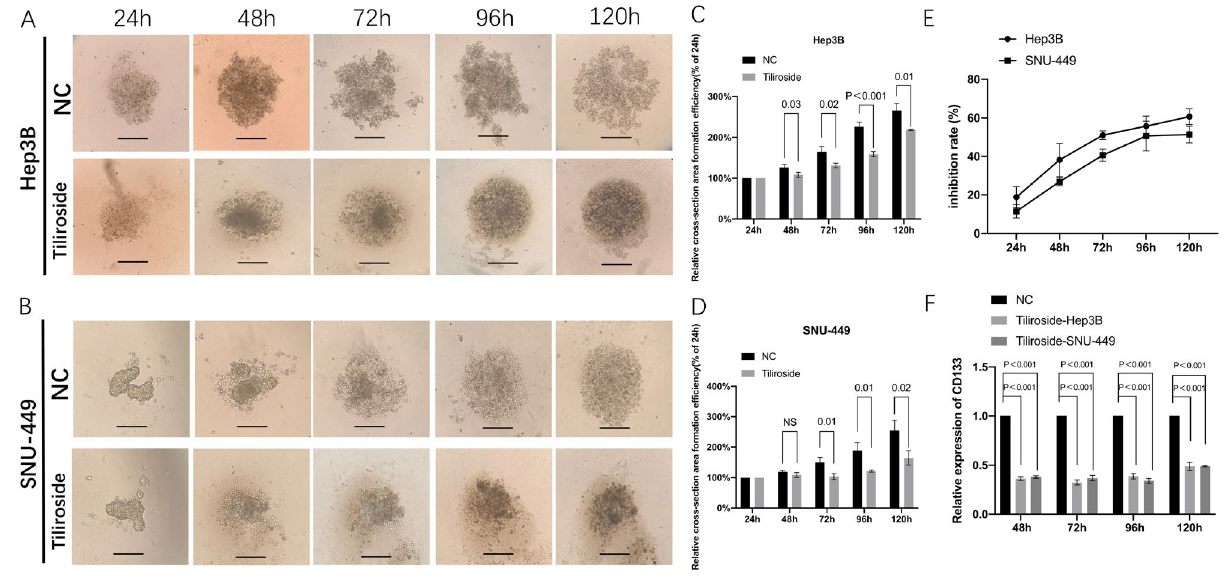
Figure 3. Tiliroside restrained the 3D formation ability and CD133 expression of Hep3B and SNU-449 cells. The representative 3D spheroid models of Hep3B ( A ) and SNU-449 ( B ) cells treated by 40 μM Tiliroside and NC. The relative cross-section area formation efficiency showed significant reduction of area of Hep3B ( C ) and SNU-449 ( D ) in Tiliroside groups. Relative inhibition rates of Hep3B and SNU-449 in response to Tiliroside were calculated by comparing the fluorescence value of Tiliroside to NC, at 24, 48, 72, 96 and 120 h, respectively ( E ). Tiliroside (40 μM) treatment significantly reduced the CD133 relative expression levels in both 3D cultured Hep3B and SNU-449 cells (P < 0.001) ( F ). NC negative